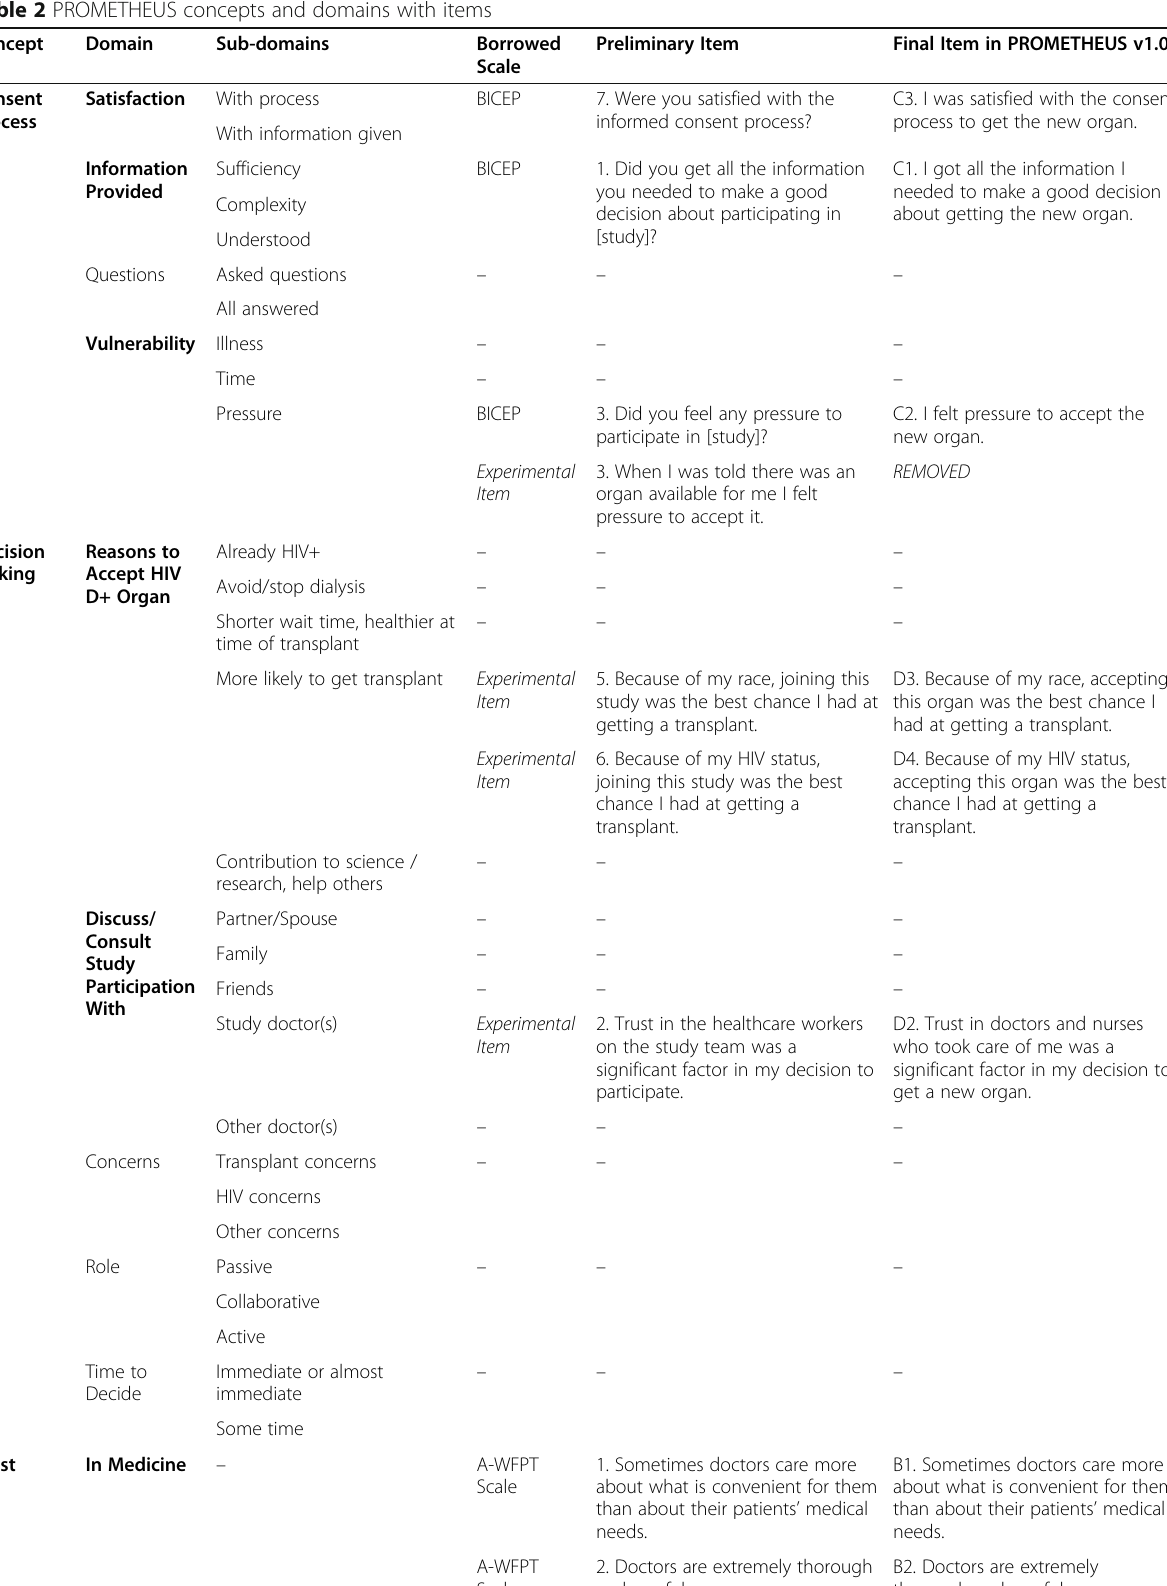
Table 2 PROMETHEUS concepts and domains with items